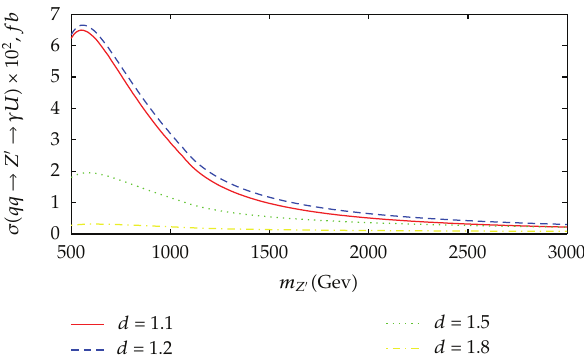
-model (cid:4) a (cid:10) 0 . 03 (cid:5) . SSM